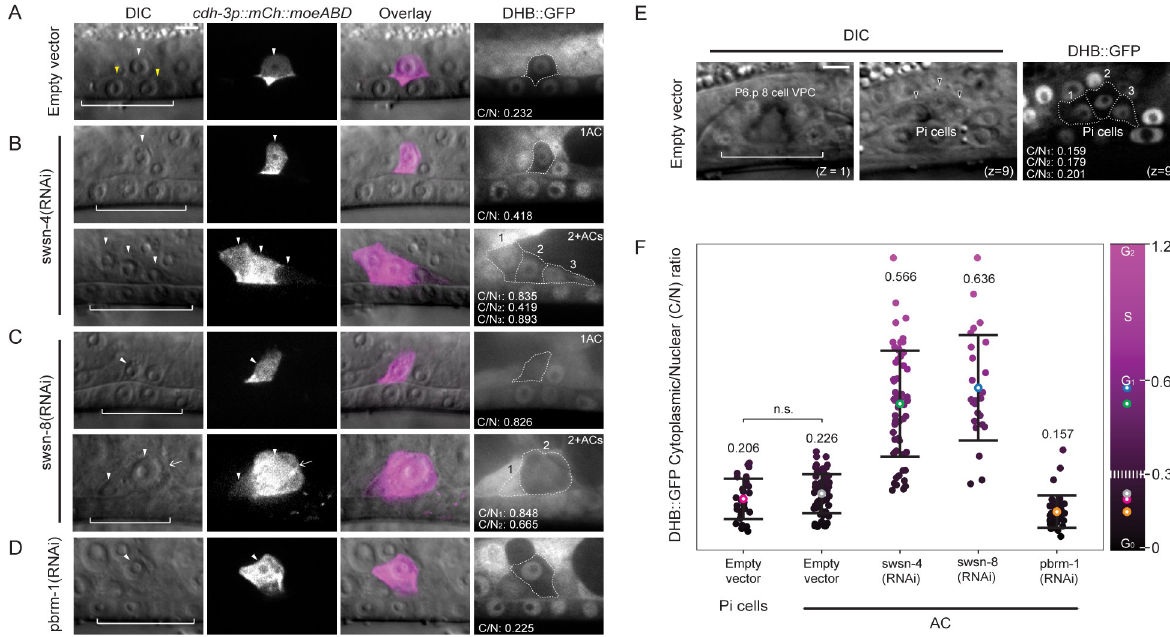
Fig 5. CDK sensor reveals SWI/SNF contribution to G 0 arrest in the AC. Micrographs depicting DIC (left), AC ( cdh-3p :: mCherry :: moeABD , center-left), DIC overlay (center-right), and DHB-based CDK activity sensor (right) in empty vector (A) and following treatment with SWI/SNF RNAi targeting subunits of the core ( swsn-4 , B) , BAF ( swsn-8 , C) and PBAF ( pbrm-1 , D) assemblies. White arrowheads indicate ACs, yellow arrowheads in A indicate boundaries of breach in BM, and white brackets indicate 1˚ VPCs. In cases where treatment resulted in multiple cells expressing the AC reporter in the same animal, representative images of both single (1AC, top) and mitotic (2+ACs, bottom) phenotypes are given, and each AC is indicated with a single white arrowhead. Quantification of the cytoplasmic:nuclear (C/N) ratio of DHB::GFP in ACs (white dotted outline) is listed in the bottom left of each panel. Mitotic ACs are numbered, and C/N ratios are provided for each (B-C) . White arrow in C indicates an AC that is out of the focal plane. (E) Representative single z-plane micrographs of the vulva at the P6.p 8-cell stage (left, z = 1) and the terminal Pi cells (middle, z = 9) in DIC, and DHB-based CDK activity sensor in Pi cells (right). Quantification of the C/N ratio of DHB::GFP in three of four Pi cells (white dotted outline) that are in the plane of the image is listed in the bottom left. (F) Quantification of C/N DHB::GFP ratios for wild-type terminally divided Pi cells and all ACs in empty vector control and each RNAi treatment (n � 30 animals per treatment). Statistical comparison was made between the mean C/N ratio of ACs in control (empty vector) compared to control (empty vector) Pi cells using Student’s t - test (n � 30 for each stage and subunit; p values are displayed above compared groups). Mean C/N ratio is represented by colored open circles and correspond to numbers above the data. Gradient scale depicts cell cycle state as determined by quantification of each Pi cell or AC in all treatments (n � 30 animals per treatment), with dark/black depicting G 0 and lighter/magenta depicting G 2 cell cycle states. Dashed white line on gradient scale bar (right) corresponds to boundaries between G 0 and G 1 phases. Colored open circles on the gradient scale correspond to the mean C/N ratio in each of the same color. n.s. not